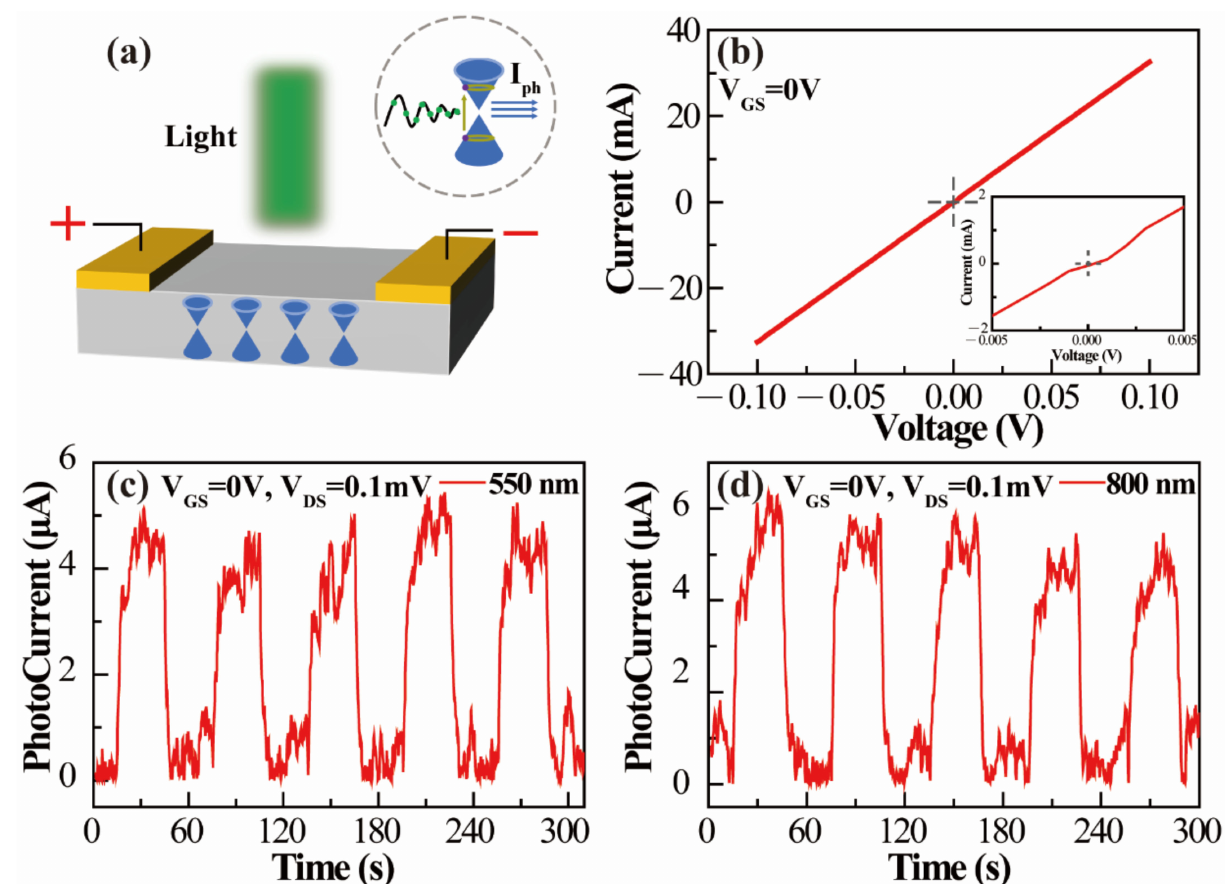
Figure 5. ( a ) Schematic diagram of NbAs photoelectric device equipment. Illustration: schematic diagram of photocurrent generation under illumination conditions. ( b ) The I–V curve of the photode- tecting prototype. ( c , d ) When the V DS = 0.1 mV, V GS = 0 V, and the incident light intensity is 10 mW, the I–T curve of the device at 550 nm and 800 nm incident light is as